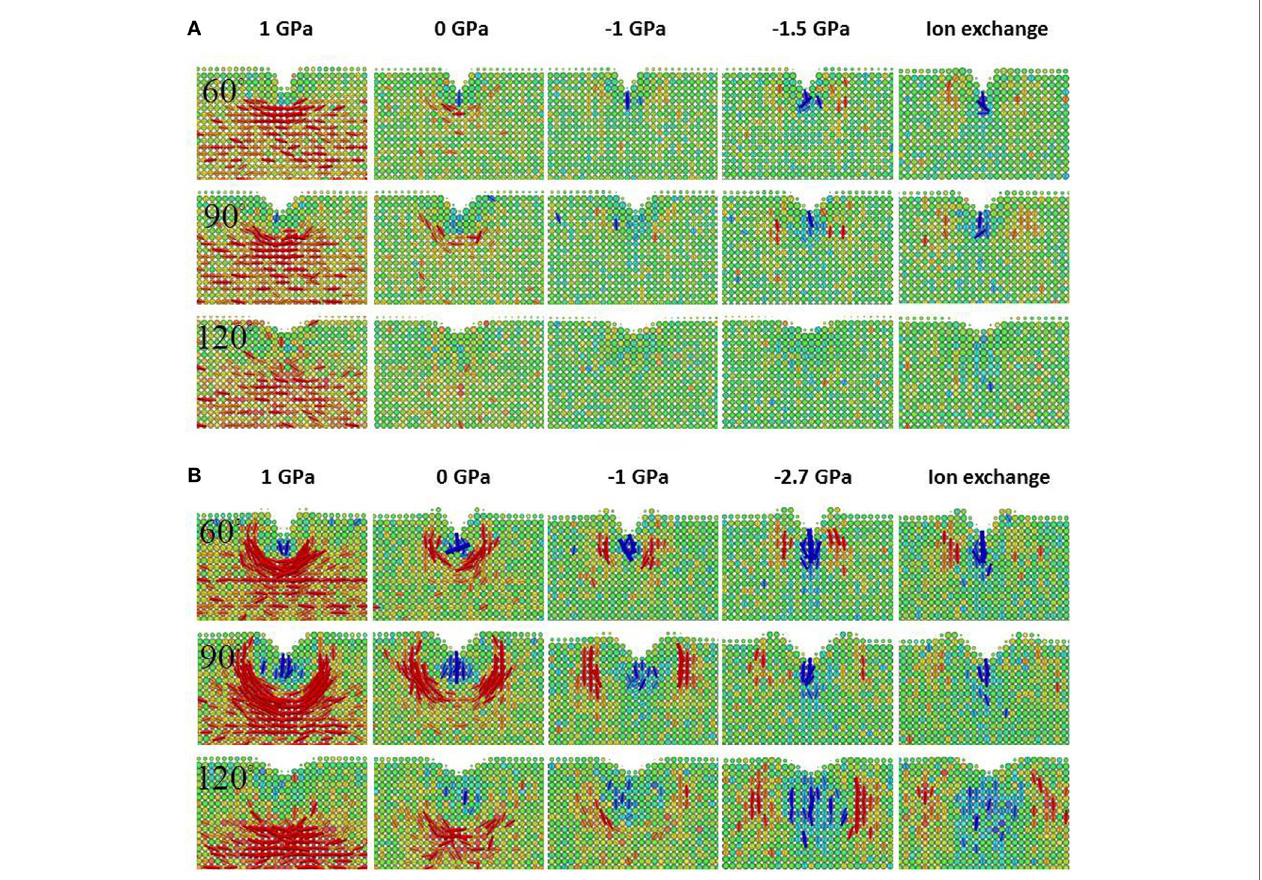
FigUre 4 | close-up view of the first principal stress field after unloading for the base glass with high free volume in (a) and low free volume in (B) . The apparent voxel size is rendered proportional to the number of atoms it contains in order to better depict the profile of the surface of the sample. The color bar is the same as in Figure 2 . From left to right, each column corresponds to a different initial σ xx as labeled on the top. The last two columns have the same initial σ xx , which is achieved via mechanical and ion exchange methods, respectively. From left to right, the free volume effectively decreases. From top to bottom, each row corresponds to the indenter angle of 60°, 90°, and 120°,